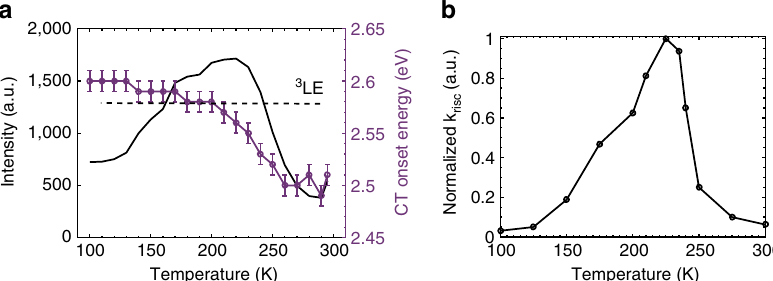
Figure 4 | Measured and calculated values of intensity and rISC rate due to change in charge transfer state energy. ( a ) The temperature dependence of the intensity (black line) and CT onset energy (purple circles). The change in CT onset energy plateaus below the T g , representative of the PEO film becoming rigid. The black dashed line represents the energy of the 3 LE at 2.58eV (refs 16,19), with the peak in intensity apparent as the CTenergy crosses resonance. The error bars are indicative of the error in the fit of 0.01eV for all points, the same error is expected on the 3 LE energy. ( b ) Relative rate of reverse intersystem crossing as a function of temperature for the D–A complex PTZ-DPTO2. The rates were extracted from the population of the 1 CTstate at 0.5ns of dynamics simulations initiated from the lowest triplet state. The full details of the model Hamiltonian and the simulations are provided in Supplementary Methods and Supplementary Tables 1 and